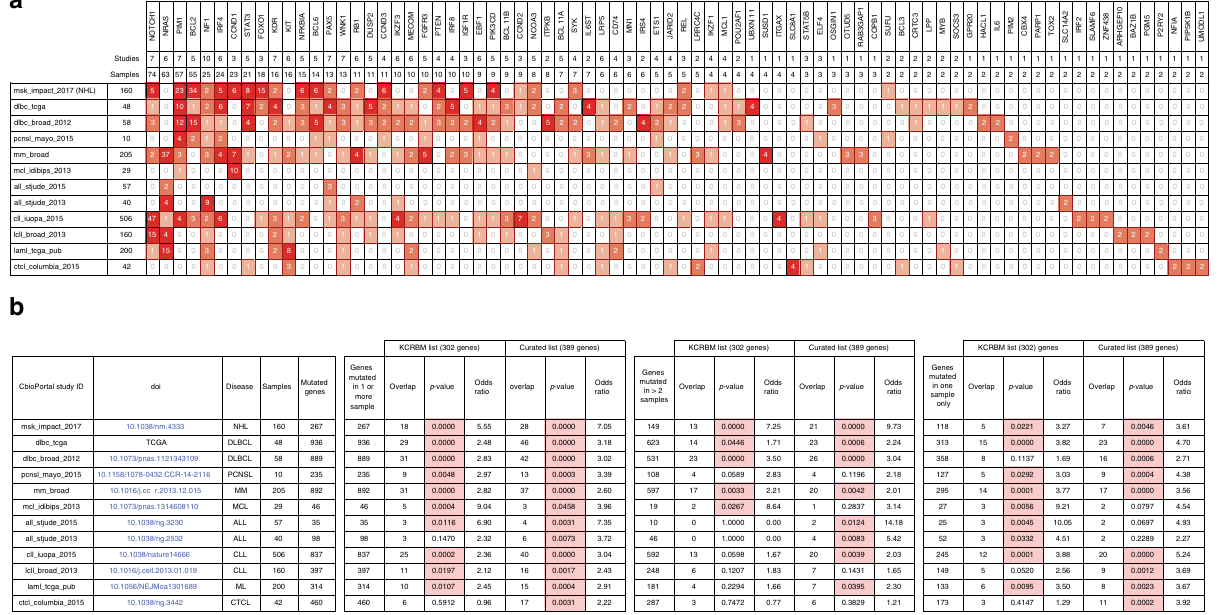
Disease Samples Mutated genes